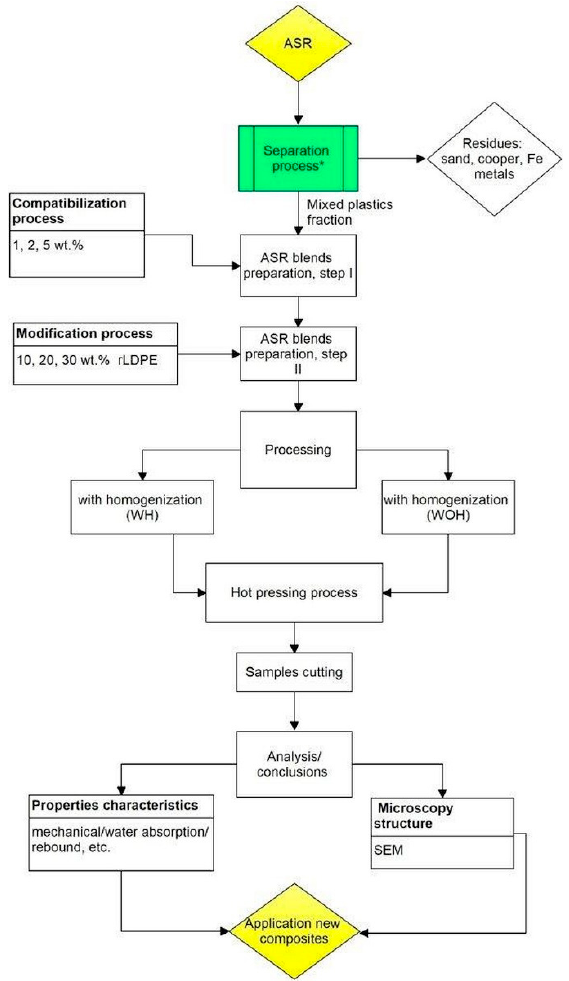
Figure 3. Scheme of the experimental procedure for ASR polymer composite. *the process developed by Euro Metall (Piotrowice, Poland) .